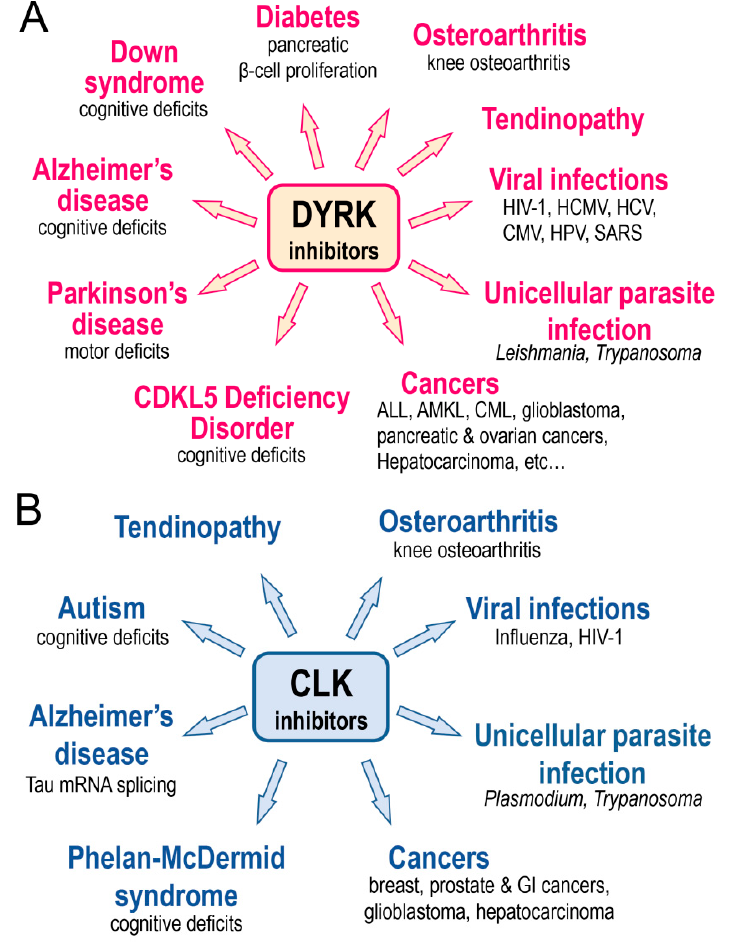
Figure 5. DYRK and CLK inhibitors and their potential use. ( A ) DYRK inhibitors (in particular inhibitors of DYRK1A) have been investigated in the indicated diseases. ( B ) CLK inhibitors (in particular inhibitors of CLK1) have been investigated in the indicated diseases.